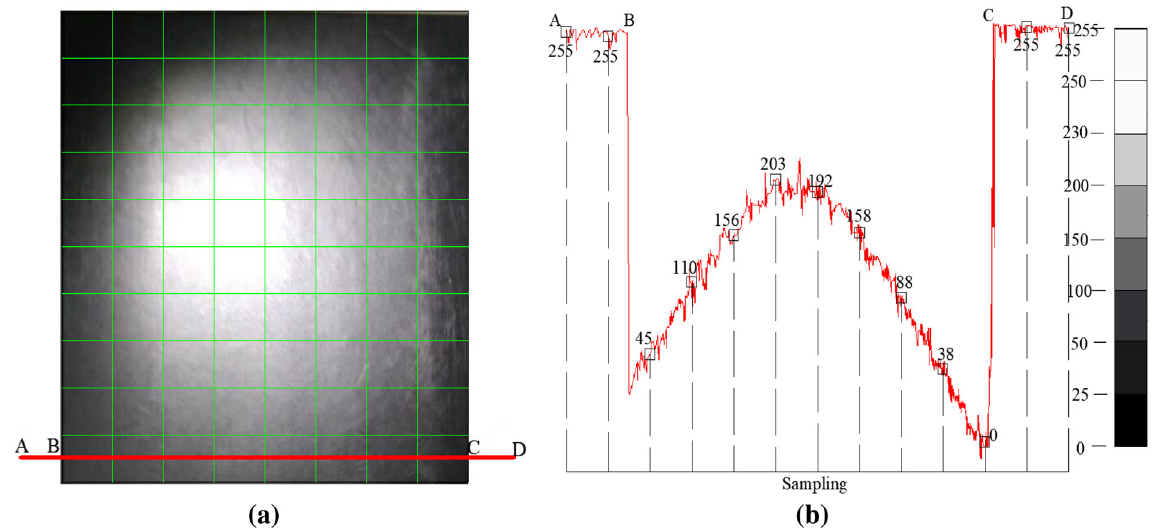
Fig. 2 Digital image formation: a continuous image, b sampling and